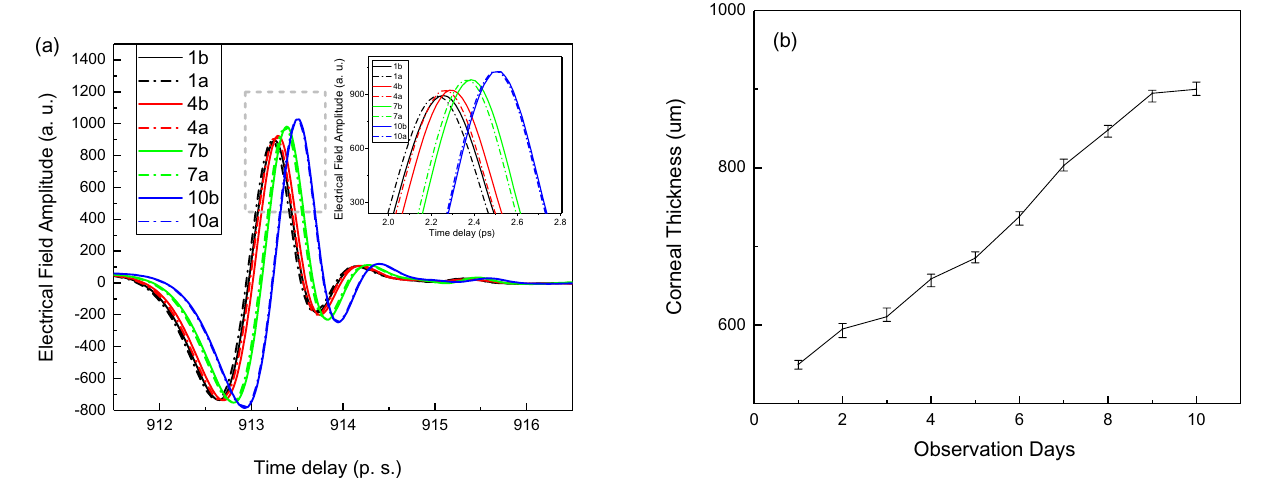
Figure 2. ( a ) Time domain spectra obtained at day 1, day 4, day 7 and day 10. Inset figure: enlarged peak information ( b ): thickness data with error bar indication versus observation